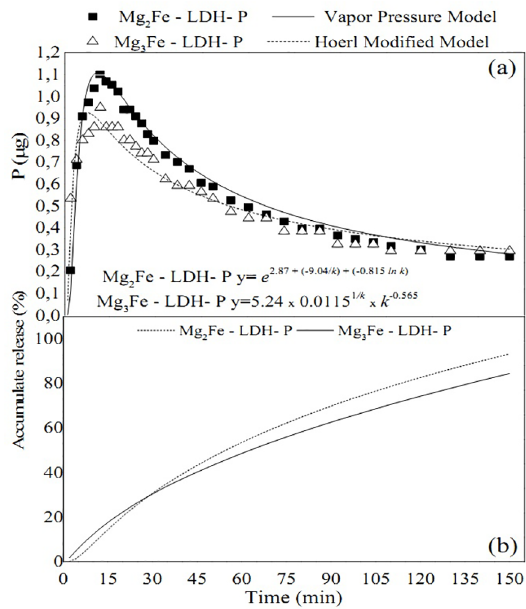
Fe-LDH-P and Mg Fe-LDH-P solutions Figure 8. P release in Mg 2 3 in relation to time. (a) release profile, (b) cumulative release rate. models. The turning point was reached at 11 min for Mg Fe- 2 LDH-P and 8 min for Mg Fe-LDH-P. Despite reaching the 3 change point more rapidly, Mg Fe-LDH-P presents lower 3 declivity than Mg Fe-LDH-P, with a longer decline phase 2 and consequently a slower release. The cumulative release rate of Mg Fe-LDH-Pand Mg Fe-LDH-P corroborates 2 3